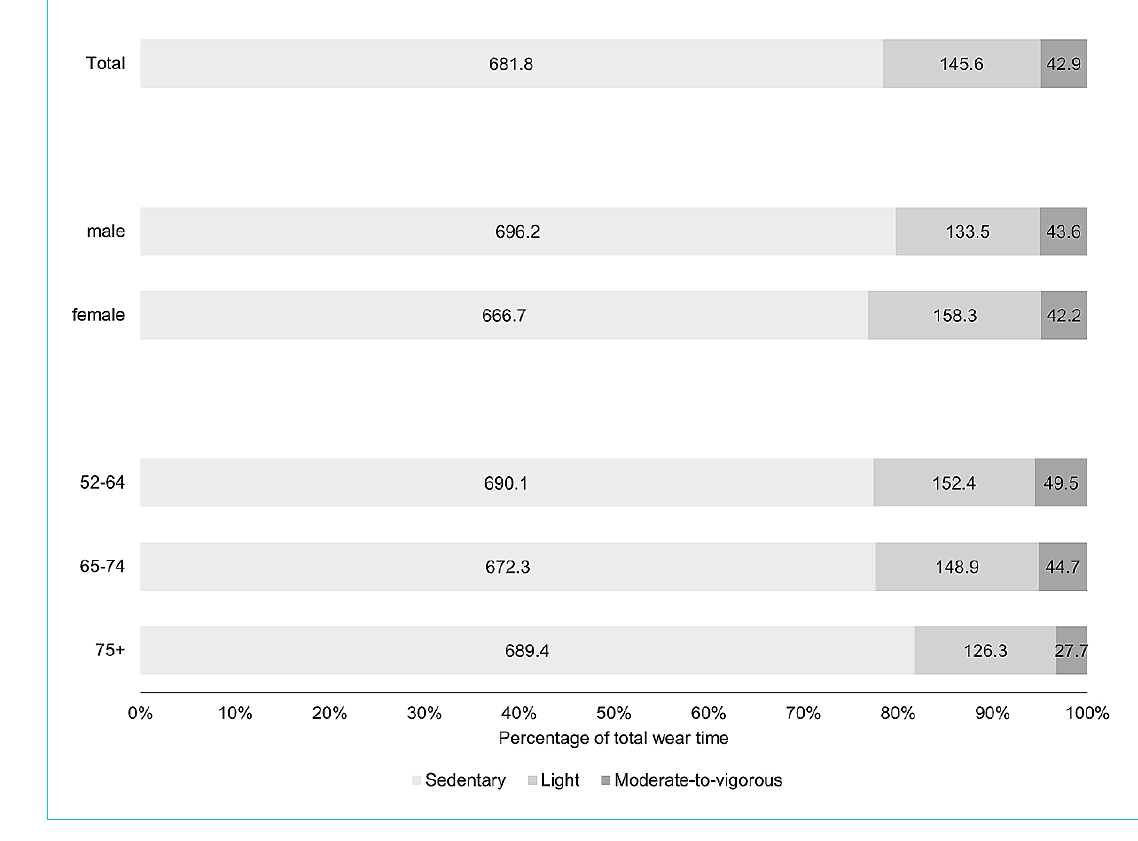
Figure 2: Average daily minutes (number in boxes) and percent of accelerometer measuring time (x-axis) spent in different levels of physical activity intensity, by sex and age group (n =